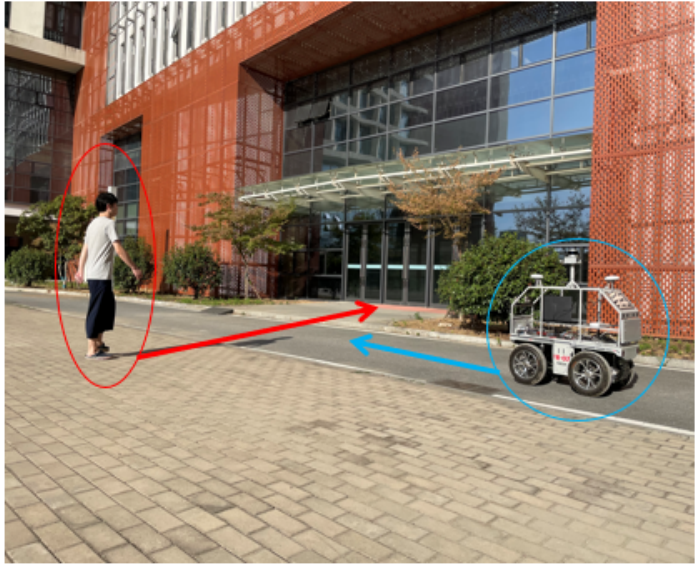
Figure 19. The stage when the vehicle and the pedestrian are far